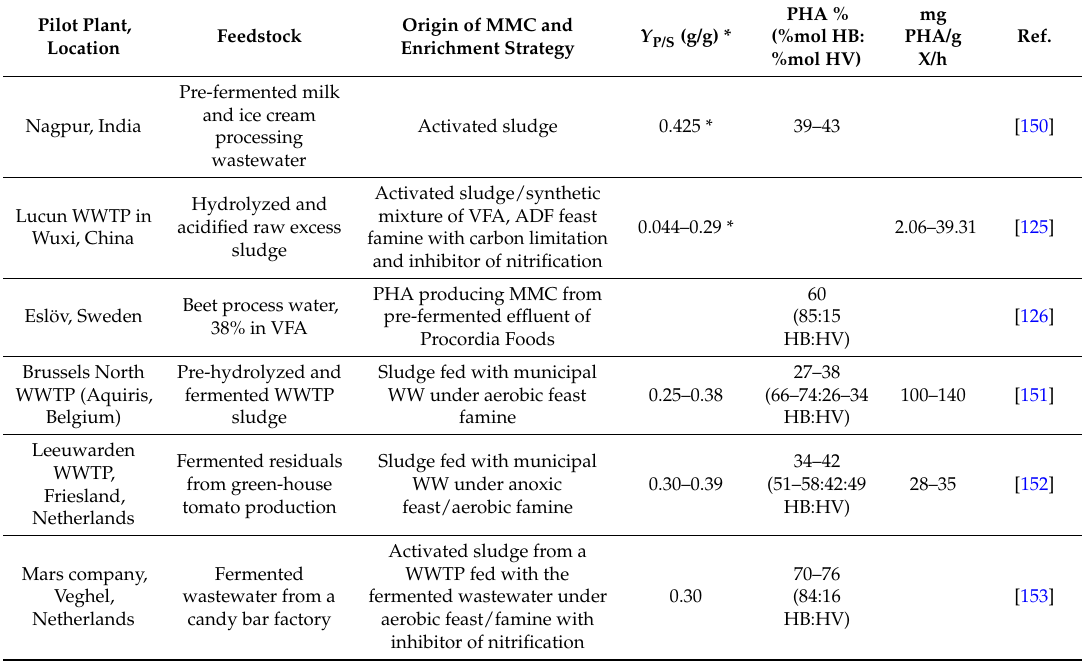
Table 4. Main characteristics of PHA production in